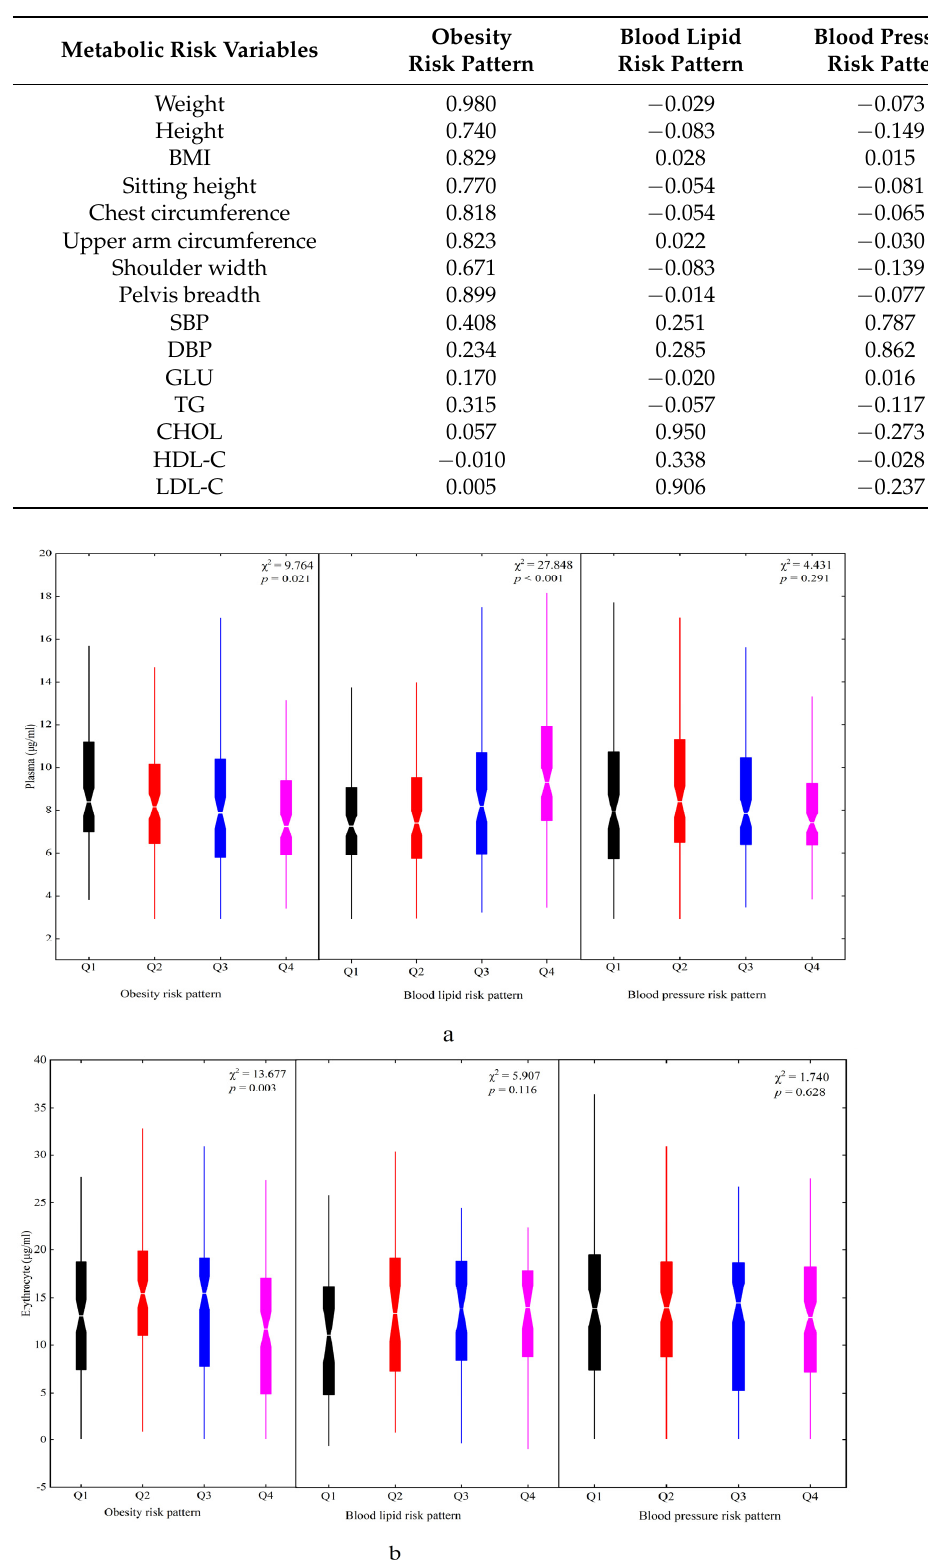
Figure 4. The plasma and erythrocyte DHA status in different metabolic risk patterns among chil- dren: ( a ) plasma and ( b ) erythrocyte. Q1~Q4 represented four quartiles of factor scores for dietary patterns: Q1, black; Q2, red; Q3, blue; Q4, magenta.